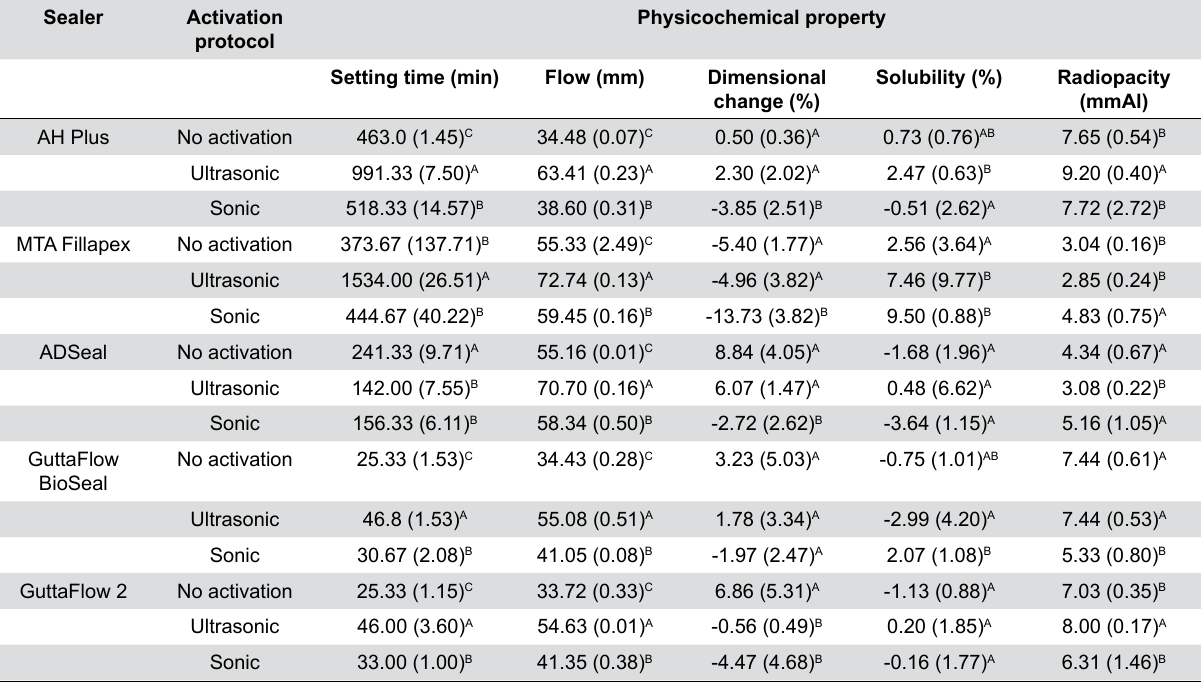
Table 1- Physicochemical properties of root canal sealers without activation, with ultrasonic activation, and with sonic activation protocols (mean±standard